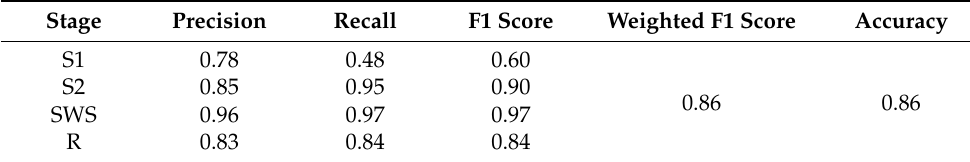
Table 3. Experiment results for test data (Exp2).